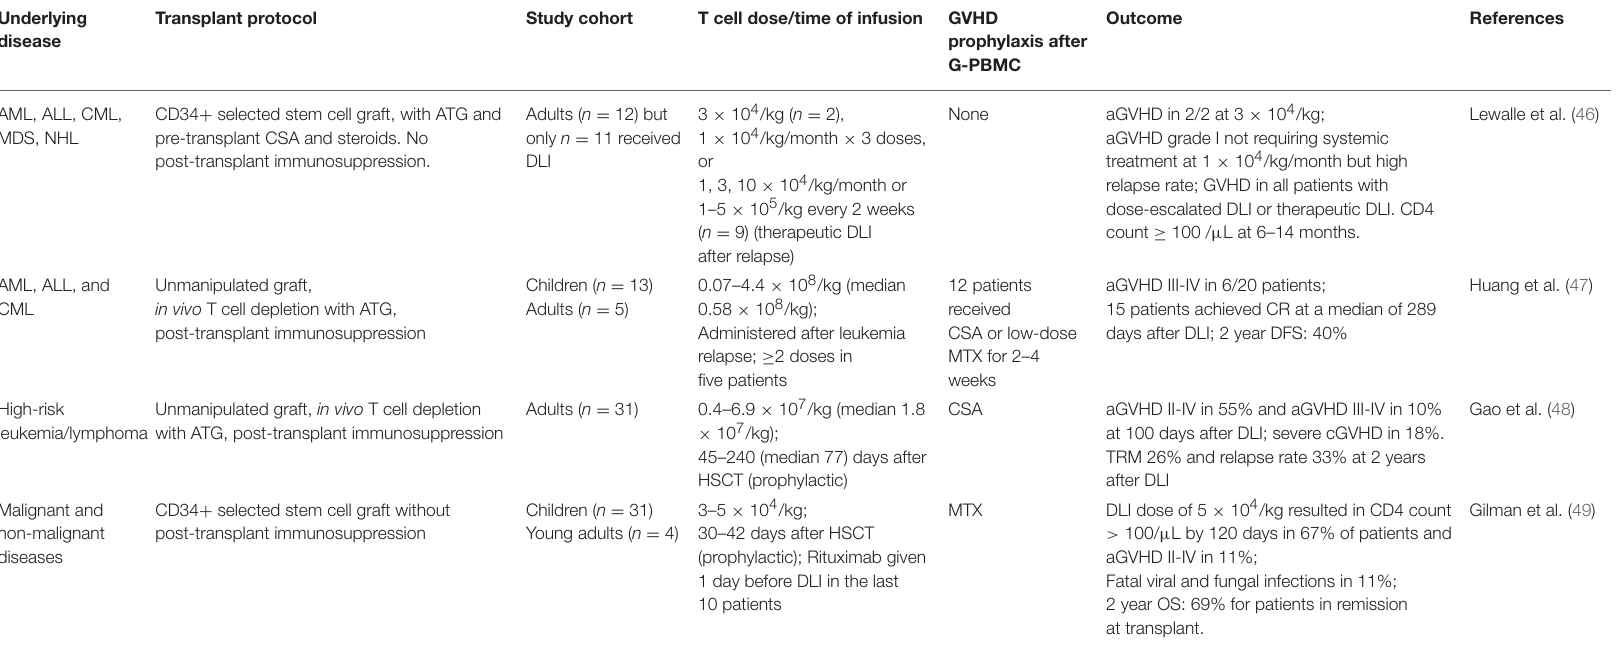
TABLE 1 | Selected studies using G-CSF primed peripheral blood mononuclear cell (G-PBMC) add-back following haploidentical HSCT. Underlying